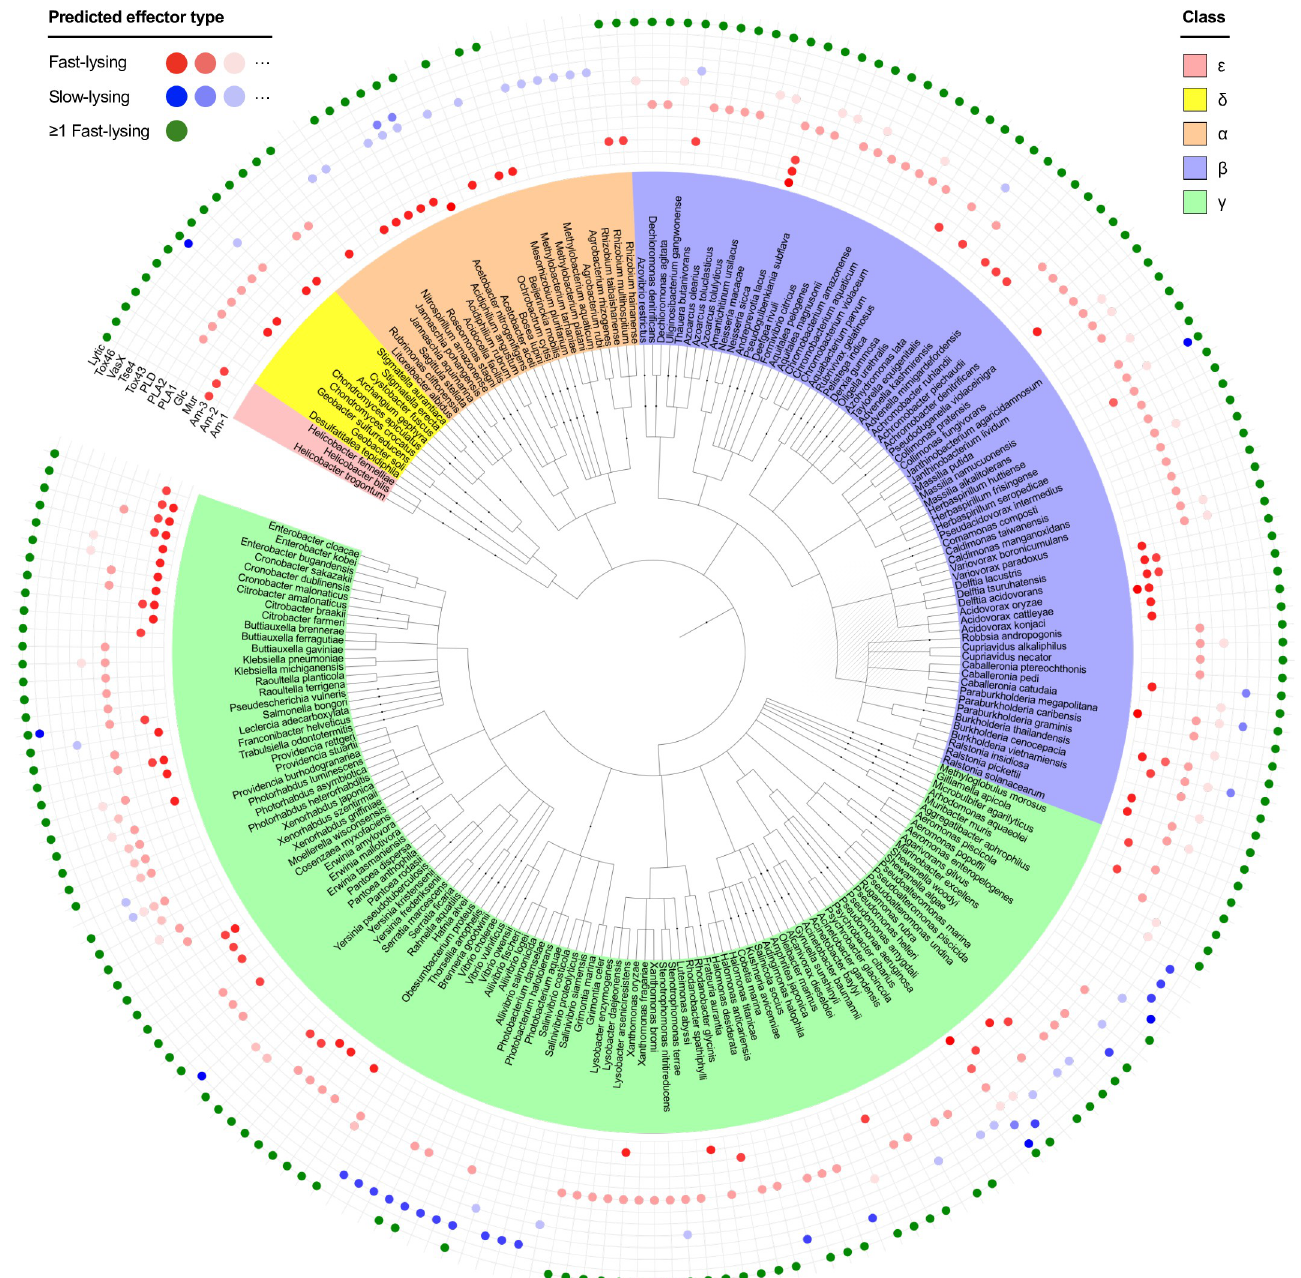
Fig 4. Taxonomy showing distribution of lytic and nonlytic T6SS toxins across the Proteobacteria. Each species is positioned in the tree according to its taxonomic classification in the NCBI taxonomy database and colored according to Proteobacterial Class ( α , β , δ , ε , γ ). Colored circles indicate the T6SS effectors associated with a single, randomly chosen strain from each species. Effectors are labeled according to their molecular target (see below); effectors expected to induce rapid cell lysis (Am-1-3, Mur, Glc, PLA1-2, PLD; “fast-lysing”) are shaded in red; those expected to lyse cells more slowly (Tox43, Tse4, VasX, Tox46; “slow-lysing”) are shaded blue. A green marker signifies that a given strain has at least 1 fast-lysing effector in its repertoire. Each species in this dataset is represented by 1 strain only, and so these data are not representative of the full toxin repertoire of any given species. However, by comparing example strains across many species, one can robustly assess preference for known lytic toxins. Plotting data from all 474 species was not feasible in 1 figure, so we plot approximately half (222) of the strains here, retaining at least 1 representative from each genus. The full tree is available to download as a separate file (S1 Data). Original data are from LaCourse and colleagues [40]; reanalyzed data are available from dx.doi.org/10.6084/m9.figshare.11980491. Am-1-3, peptidoglycan amidases; Mur/Glc, peptidoglycan glucosidases; NCBI, National Center for Biotechnology Information; PLA1-2 and PLD, phospholipases; Tox43, DNases; Tox46; NAD(P)+ glycohydrolases; Tse4/VasX, pore-forming.